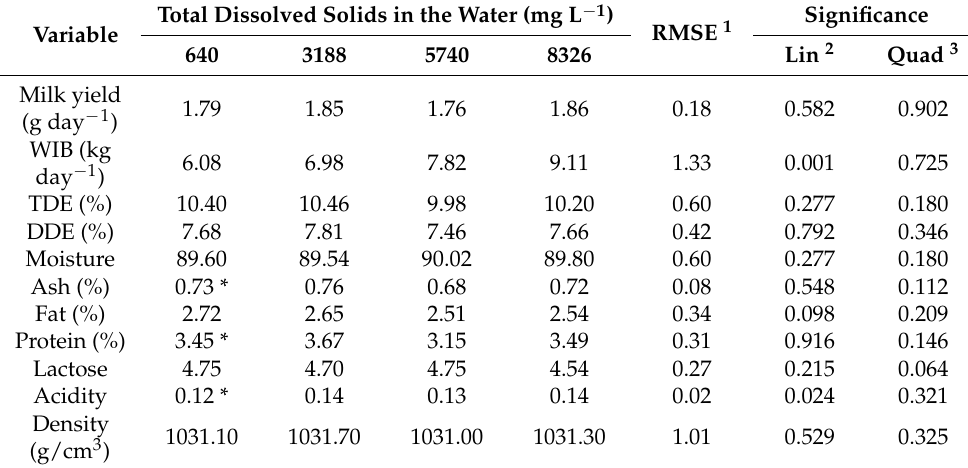
Table 4. Physicochemical composition of milk of goats of the Alpine breeds subjected to treatments with increasing levels of total dissolved solids over a period of 48 days of exposure.